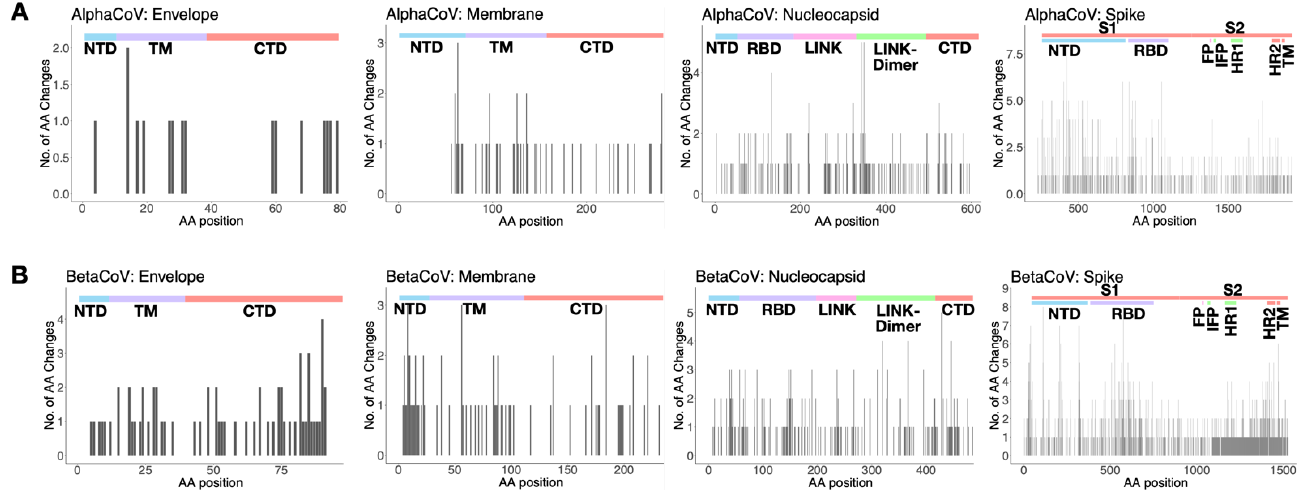
Figure 5. The number of inferred amino acid changes (AA) associated with the sHCoVs for AA positions in the envelope, membrane, nucleocapsid, and spike proteins from datasets D4 and D5. Panel ( A ) represents the aggregated AA changes from the alphaCoVs 229E and NL63 while ( B ) represents the aggregated changes from the betaCoVs OC43 and HKU1. At the top of each plot, the functional domains or regions of the respective proteins are shown; NTD = N-terminal domain, TM = transmembrane domain, CTD = C-terminal domain, RBD = receptor binding domain, LINK = central linker domain, LINK-Dimer = dimerization domain, S1 subunit, S2 subunit, FP = fusion peptide, IFP = internal fusion peptide, HR1 = heptad repeat 1, and HR2 = heptad repeat.